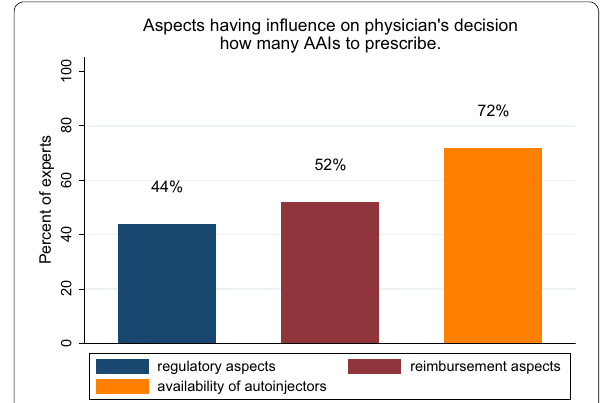
Fig. 4 Proportions of experts being influenced by regulatory, reimbursement and availability aspects in their decision regarding number of AAIs per one